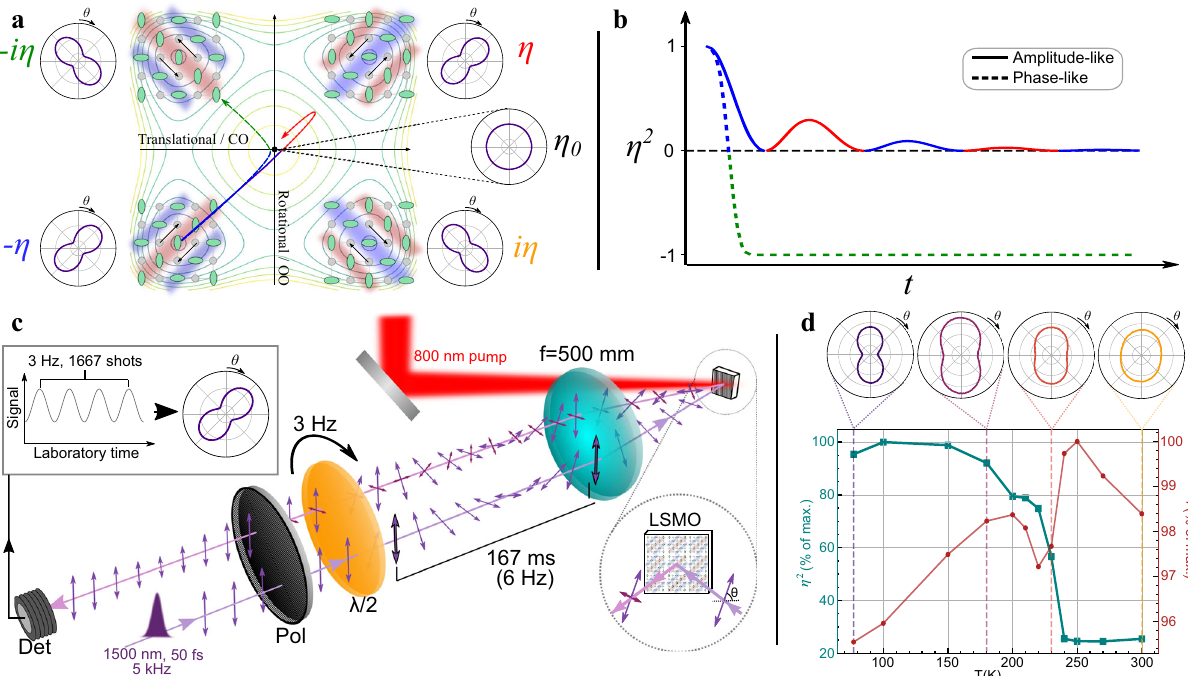
Fig. 2 C4 symmetry breaking and re fl ection anisotropy in La0.5Sr1.5MnO 4 . a Schematic representation of the potential energy surface of the symmetry- broken phase. The four minima (± ƞ , ±i ƞ ) correspond to the directions along which the low temperature phase can form, relative to the high-symmetry structure, labelled ƞ 0 . Inserts show the re fl ection anisotropy signal for each domain structure, which can point along the [110] or [1 – 10] crystallographic axis. Domains of opposite parity have the same anisotropy and are thus indistinguishable. b . Expected signals for ƞ 2 based on the two pathways shown in a . An amplitude-mode-like motion, in which the order is restored along a direct pathway, but overshoots, resulting in a “ rebound ” in the signal, and a phase- like motion, which fl ips the anisotropy axis (Line colour corresponds to the domain state). c Experimental setup for measurement of time-dependent anisotropy. A 60 fs 1500 nm probe pulse passes through a linear polarizer and rotating a halfwave plate. The probe is focused onto the LSMO sample, where the polarization component parallel to the input state is attenuated and a transverse component with a complex phase delay is introduced. The re fl ected beam is collected by the same lens and propagates back through the waveplate, where the initial polarization rotation is undone. The beam then passes back through the linear polarizer, removing the transverse polarization component introduced by the LSMO, and the modulated parallel component is collected on a photodiode. The real time-modulation of the signal is processed to yield the angular anisotropy signal (inset, top left). d ƞ 2 and r as a function of temperature in our single-crystal LSMO sample. The polar plot radial axes run from 1.42 to 1.8 with divisions marked every 0.1 (arb. units). ƞ 2 shows a clear discontinuity at